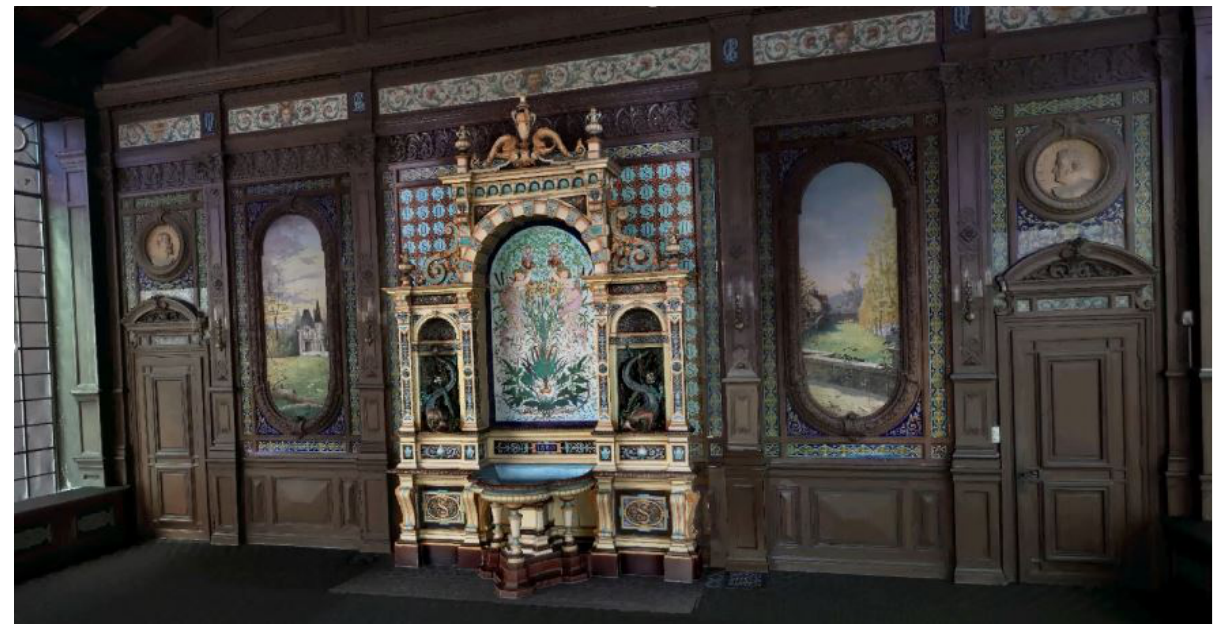
Figure 3. Accurate 3D textured model of the Winter Garden